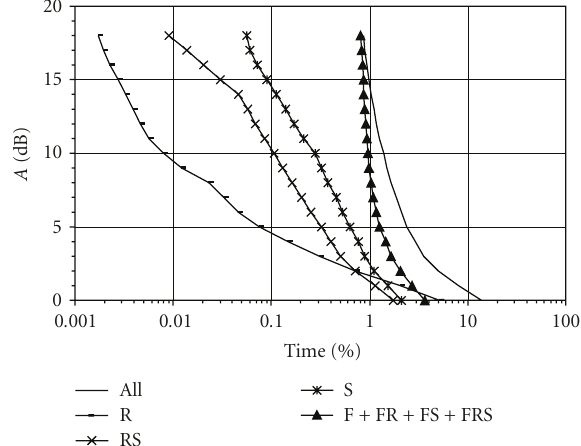
Figure 4: Obtained yearly CDs of attenuation due to all the hydrometeors combined on the FSO path for the individual year periods.